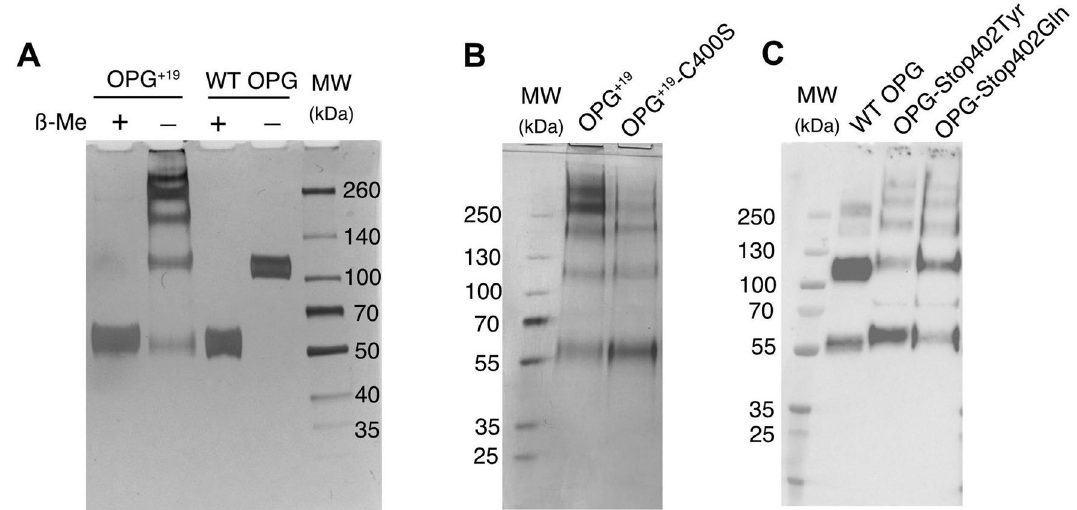
Figure 2. OPG +19 tend to form large oligomeric complexes. ( A ) SEC purified WT dimer (fraction S7-S10 from Fig. 1C) and OPG +19 (fraction S5 from Fig. 1C) were resolved by SDS-PAGE and visualized by silver staining. Samples were run either under non-reducing condition to preserve intermolecular disulfide bound, or reduced with 2-Me. ( B ) SEC purified OPG +19 and OPG +19 /Cys400Ser compound mutant (OPG +19 -C400S) were visualized by silver staining under non-reducing condition. ( C ) 293F cells were transfected with WT OPG, OPG-Stop402Tyr or OPG-Stop402Gln mutants, and the culture medium were harvested 3 days post transfection and resolved by SDS-PAGE. The gel was blotted with rabbit anti-OPG polyclonal